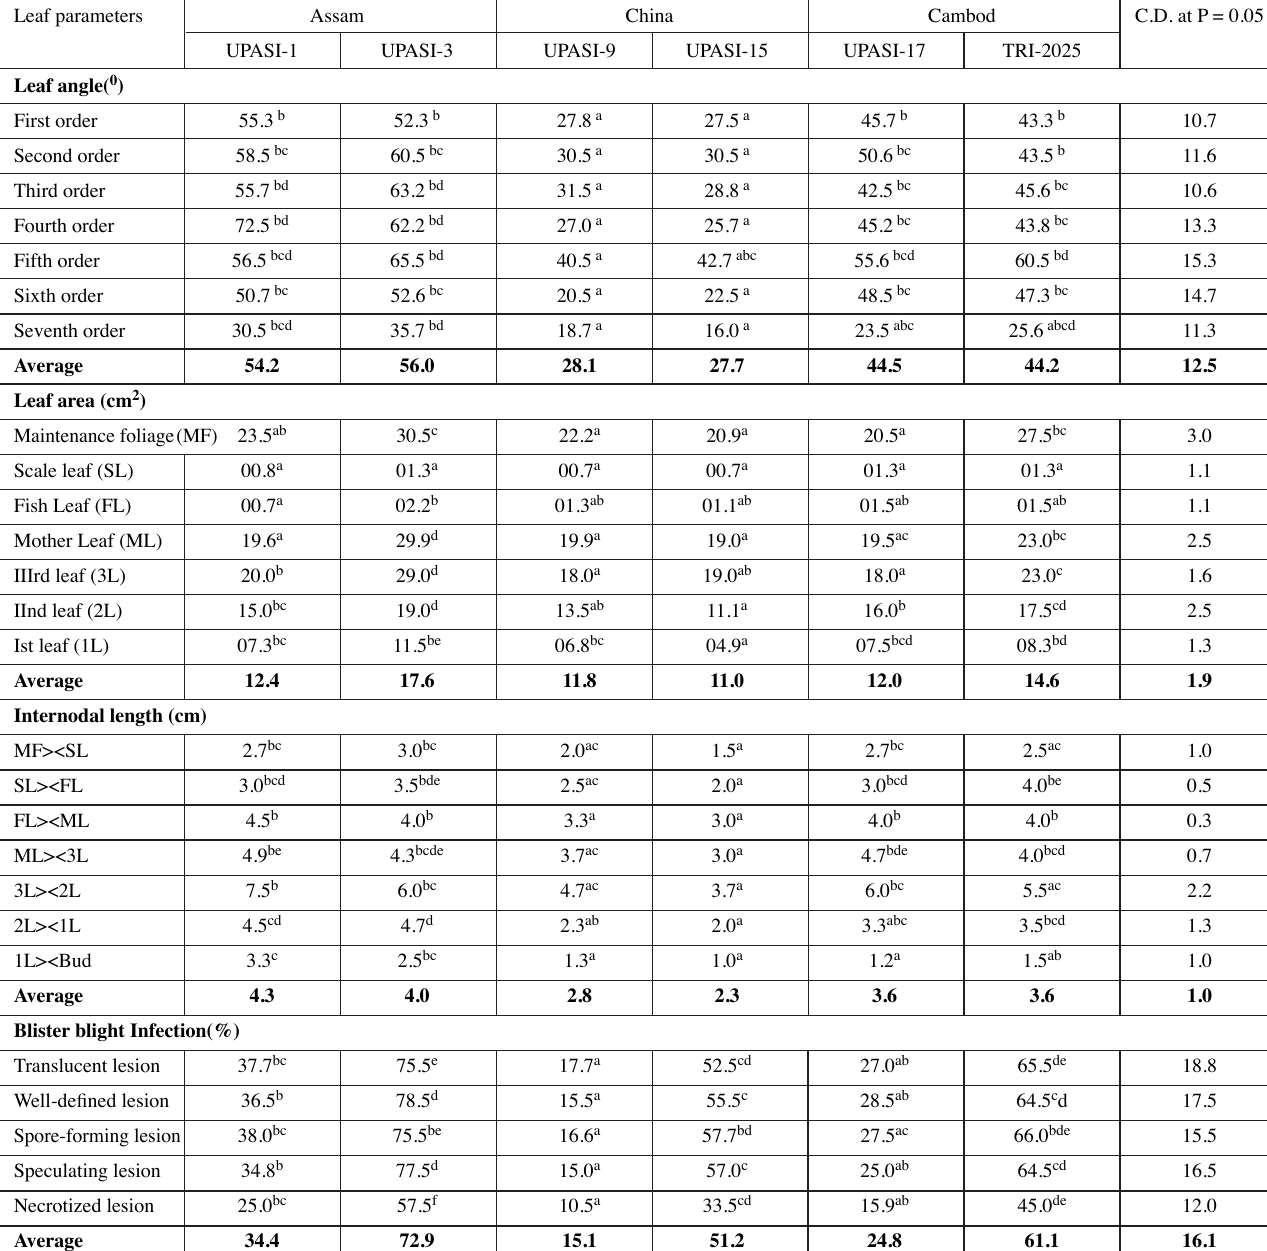
Tab. 3: Leaf architectural parameters of various tea clones and blister blight disease incidence Leaf